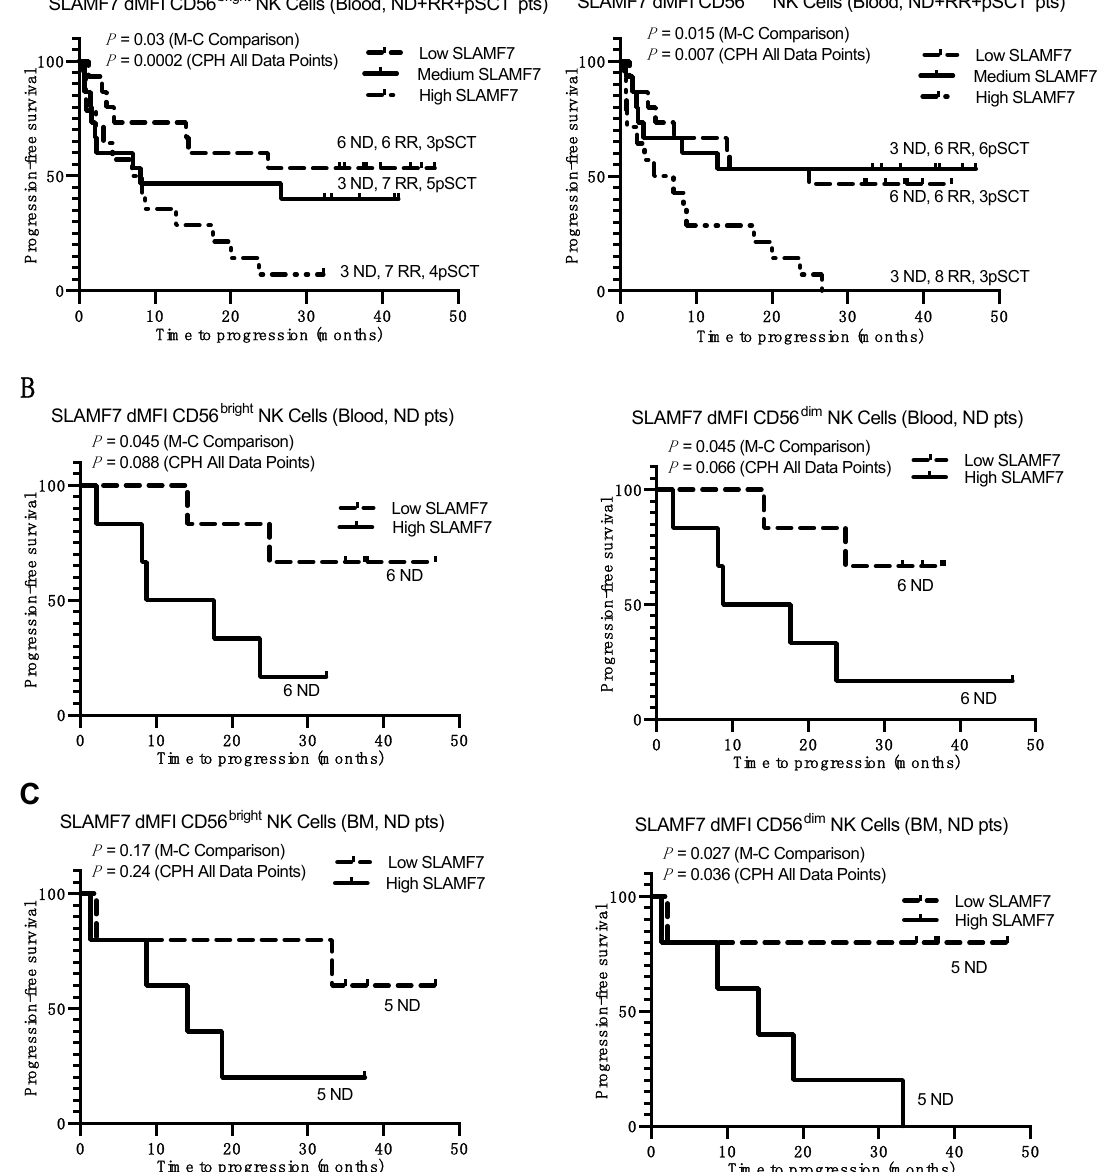
Figure 4. Kaplan–Meier survival plots showing time to progression as a function of SLAMF7 expression on NK cells in blood and BM. ( A ) Plots for the combined ND+ RR+ pSCT MM patients divided into tertiles based on their dMFI values for SLAMF7 expression on CD56 bright (left) and CD56 dim NK cells (right) in blood. Numbers of patients in each tertile that are ND, RR, or pSCT are indicated adjacent to each plotted line. ( B , C ) Plots for only ND MM patients divided into halves above and below the median of dMFI values for SLAMF7 expression on their CD56 bright (left) and CD56 dim NK cells (right) in peripheral blood ( B ) and BM ( C ). Line designations for high-, medium-, and low-expression tertiles and halves are indicated in the individual panels. p values are listed for a Cox proportional hazards (CPH) test performed on all data points and Mantel–Cox (M–C) statistical analysis of each patient group divided into tertiles or halves.